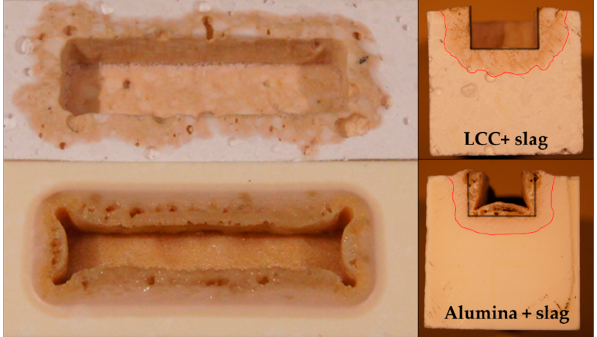
Figure 4. Comparison of the corroded area of the low cement castable (LCC) ( top ) and alumina ( bottom ) samples after corrosion test with slag.